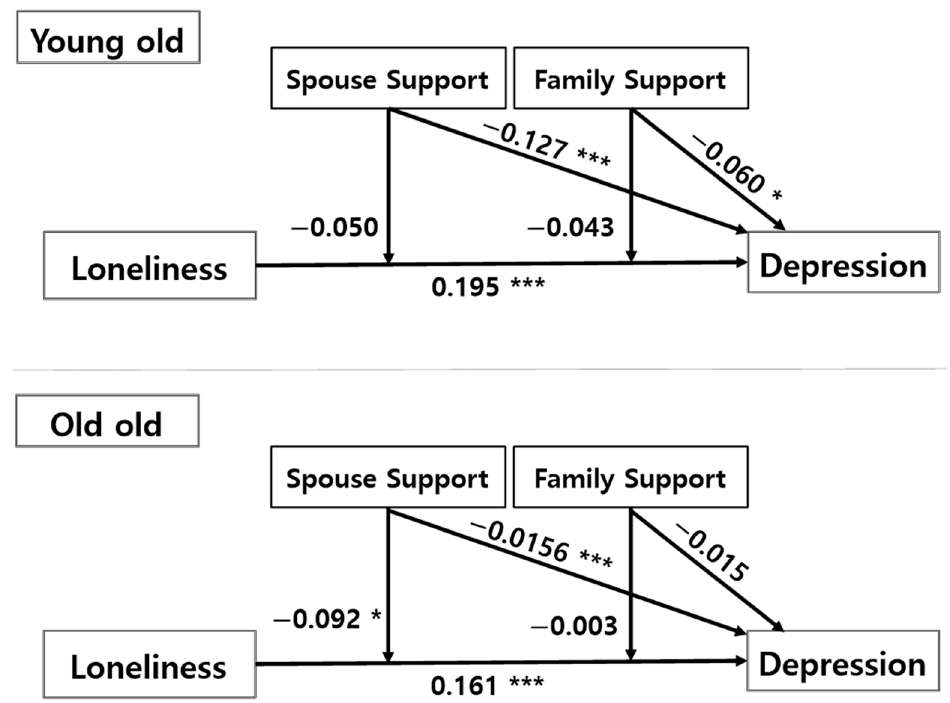
Figure 2. Model of Moderation by Social Support: Young-Old and Old-Old. Note: * p < 0.05, ** p <